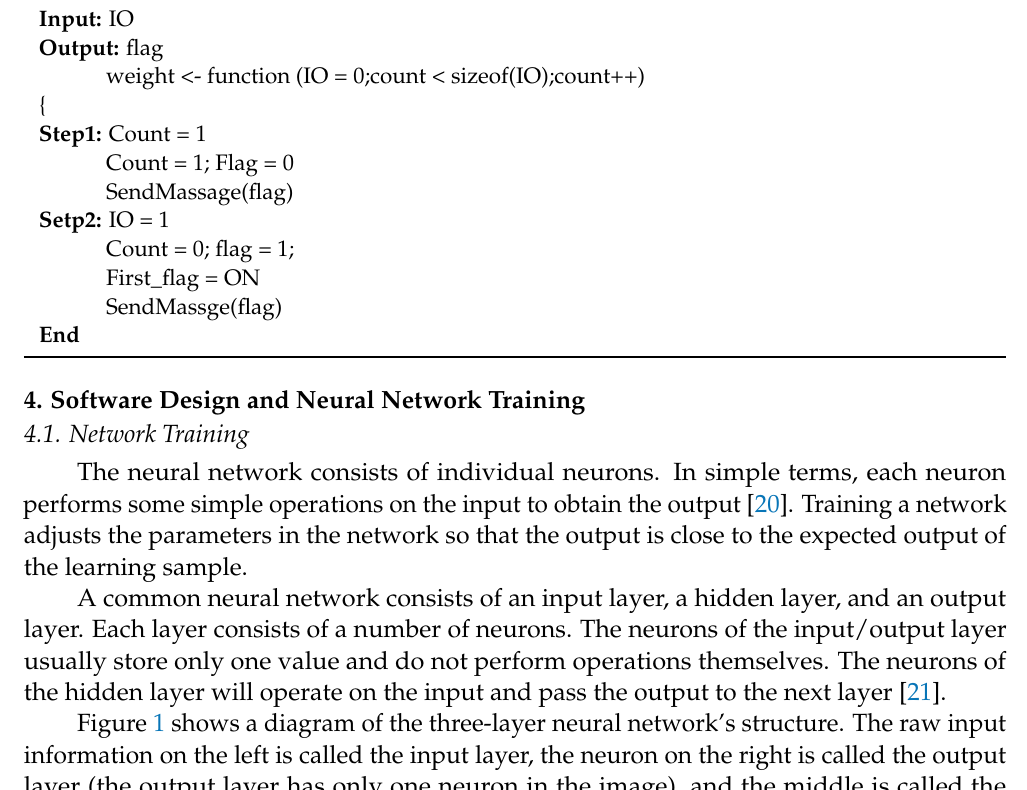
Figure 2. The neural network model constructed in this system. The prediction model worked as follows. Step 1. Input signals are X 1 , X 2 , X 3 , X 4 , X 5 , …, X 14 Step 2. The connection weights from the input layer to the hidden layer are W kj , where k denotes the number of neurons and j denotes the number of hidden layer neurons. For example, W 14 represents the connection weight between the first neuron and the fourth node of the hidden layer. 4.2. Neurons A neuron is a node of a neural network. Each neuron model has input, computational processing, and output capabilities. In the neuron network model shown in Figure 3, x 1 and x 2 are the input vectors. Weights are given when entering the input layer, and several input vectors are given several weights, such as x 1 w 1 and x 2 w 2 . When the node z is reached, x 1 w 1 and x 2 w 2 are operated by the activation function g(z) [17], and finally the result a is output, and the operation of one neuron node is completed. Figure 3. Neuron node model diagram. 4.3. Convolutional Neural Network